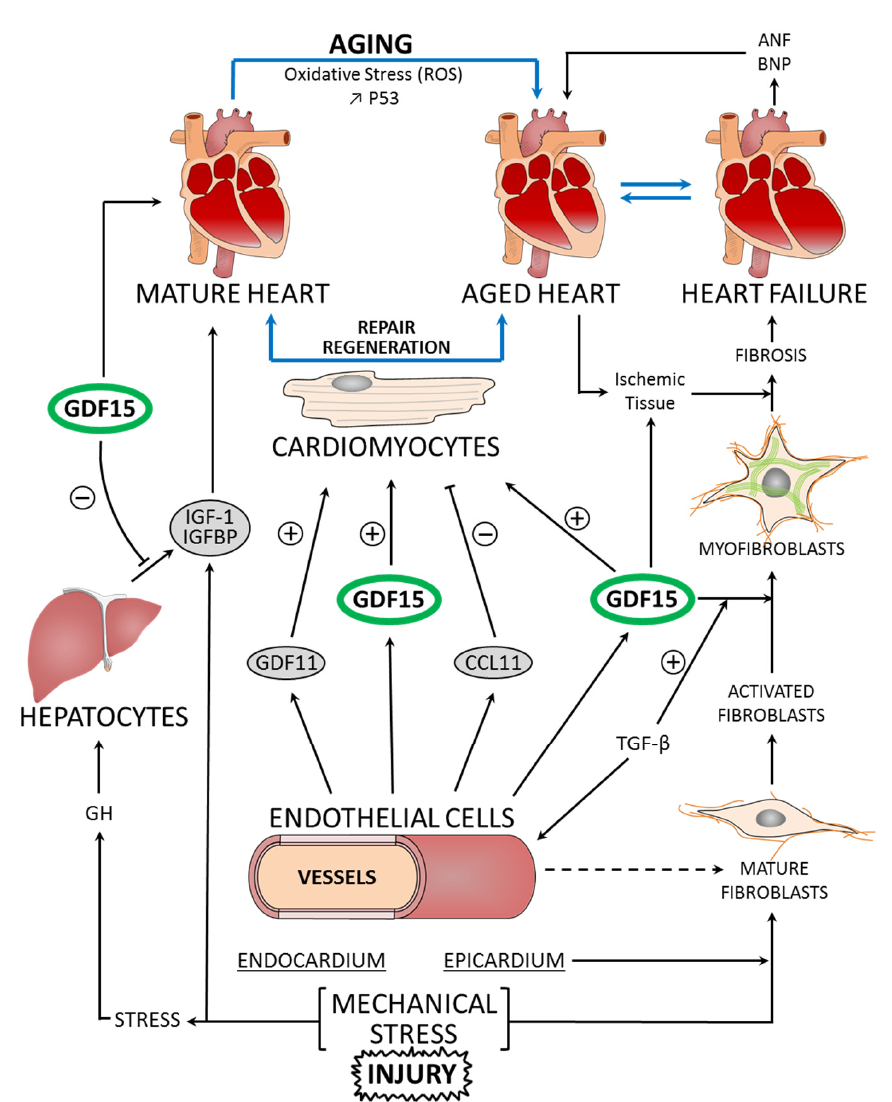
Figure 1. Molecular pathways linking mature heart, aged heart, and heart failure to GDF15 function, in the regulation of cardiomyocyte repair and regeneration. Aging is characterized by increased oxidative stress through reactive oxygen species (ROS) production and DNA damage. The mechanical stress and injury on the myocardium induce the secretion and release of GDF15. GDF15 shows a cardioprotective effect on the cardiomyocytes of ischemic tissue. Other endogenous factors, such as GDF11 and CCL11, also influence the regeneration process. The development of fibrosis is correlated with heart failure. The transformation of cardiac fibroblasts to myofibroblasts is a process in the adaptation of the myocardium to stress. GDF15 and TGF- β are factors controlling this transformation. In heart failure, ANP and BNP, but also GDF15, are synthesized as prohormones and become active hormones. Insulin-like growth factor 1 (IGF1) signaling acts as an important modulator of cellular functions through its receptors: IGF1-R. Growth hormone (GH) secreted from the pituitary gland sends signals to the liver to stimulate the production of IGF1. In the blood, GDF15 levels act on the liver inducing an inhibition of the actions of GH (+: stimulation; − : inhibition; ↑ : inhibition; : increase).